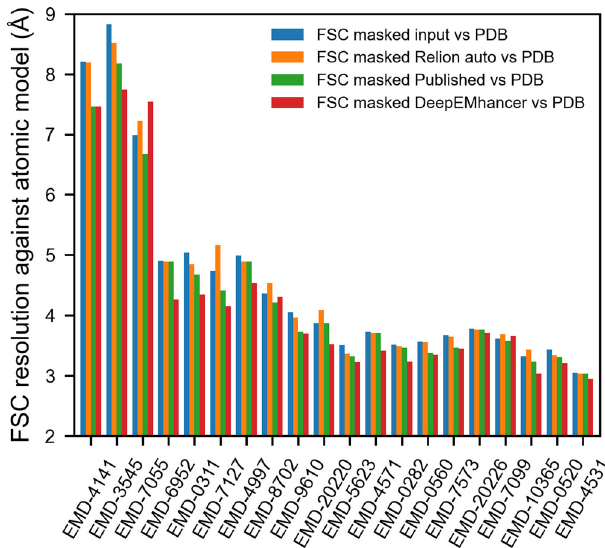
Fig. 3 DeepEMhancer produces better results than global B -factor-based methods. Resolution (determined by Fourier shell correlation coef fi cient, FSC) between the reference maps obtained from the atomic model and (1) the input maps (blue), (2) the post-processed maps obtained with Relion postprocessing automatic B -factor (orange), (3) the post-processed maps deposited in EMDB (green), and (4) the post-processed maps obtained with DeepEMhancer (red). EMDB entries are sorted by published global